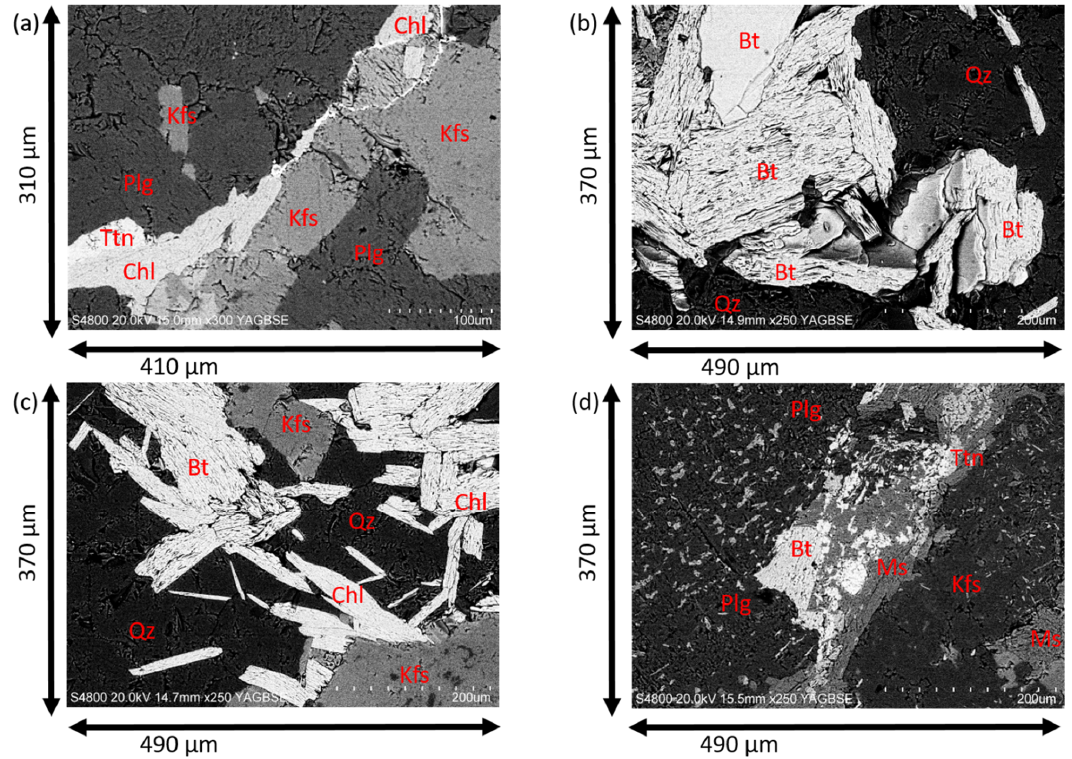
Figure 4. SEM results. ( a ): Plagioclase and feldspar grains, and chlorite grains. ( b ): Biotite lamellae and quartz grains. ( c ): Quartz grains, Potassium feldspar grains, Biotite and chlorite lamellae. ( d ) Plagioclase and feldspar grains. Biotite and muscovite lamellae. Legend: Bt: Biotite, Chl: Chlorite, Kfs: Potassium feldspar, Ms: Muscovite, Plg: Plagioclase, Qz: Quartz, Ttn: Titanite.